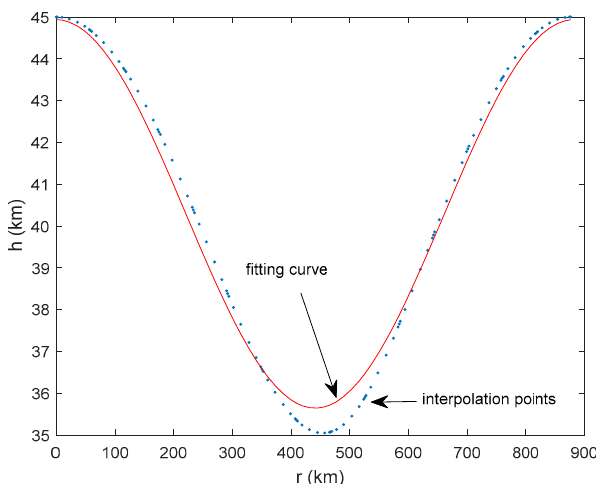
Figure 1. Optimal periodic altitude at the initial altitude of 45 km.